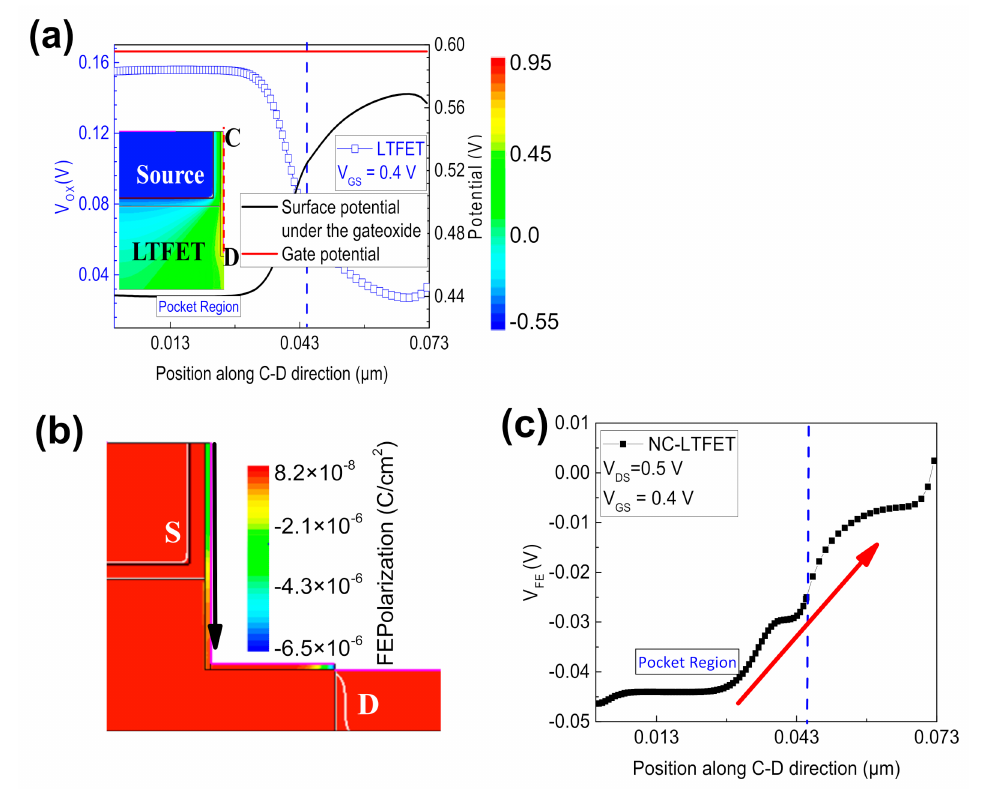
Figure 5. ( a ) The surface potential under the LTFET’s gate oxide along the C-D direction, the gate potential of LTFET and the voltage across gate oxide layer of LTFET are also considered, ( b ) polarization distribution of NC-LTFET at V GS = 0.4 V and V DS = 0.5 V and ( c ) the voltage across the ferroelectric gate oxide layer along the C-D